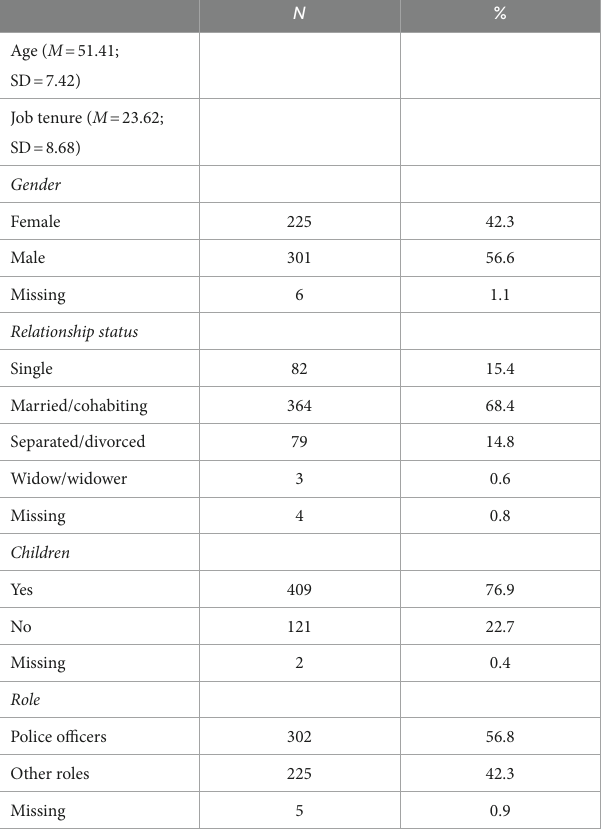
TABLE 1 Descriptive statistics of the sample ( N =